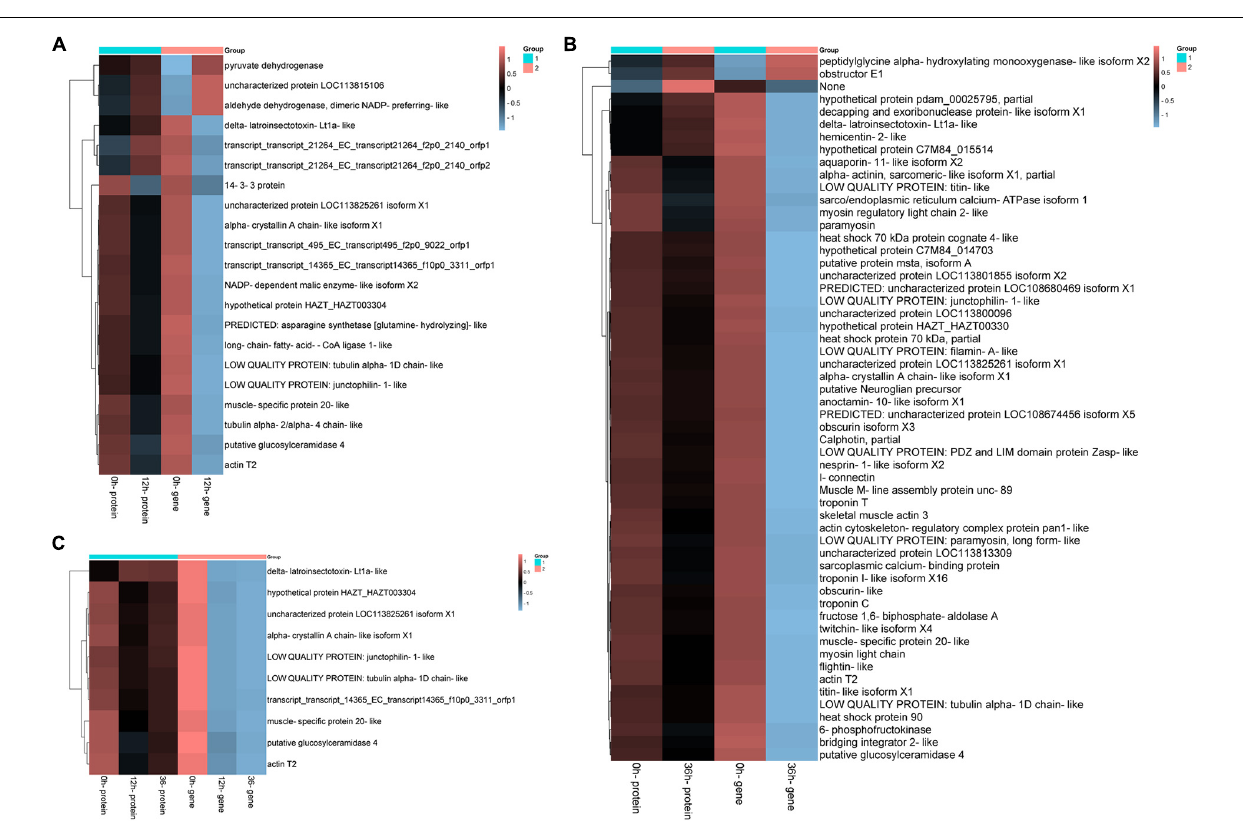
FIGURE 9 | Significantly enriched differentially expressed genes (DEGs)/differentially expressed proteins (DEPs) in both transcriptome and proteome. (A) Hierarchical cluster analysis of 21 DEGs in 0 vs. 12 h group. (B) Hierarchical cluster analysis of 60 differentially expressed genes in 0 vs. 36 h group based on the data of log ratio fold change. (C) Hierarchical cluster analysis of 10 pairs of protein gene pairs in both